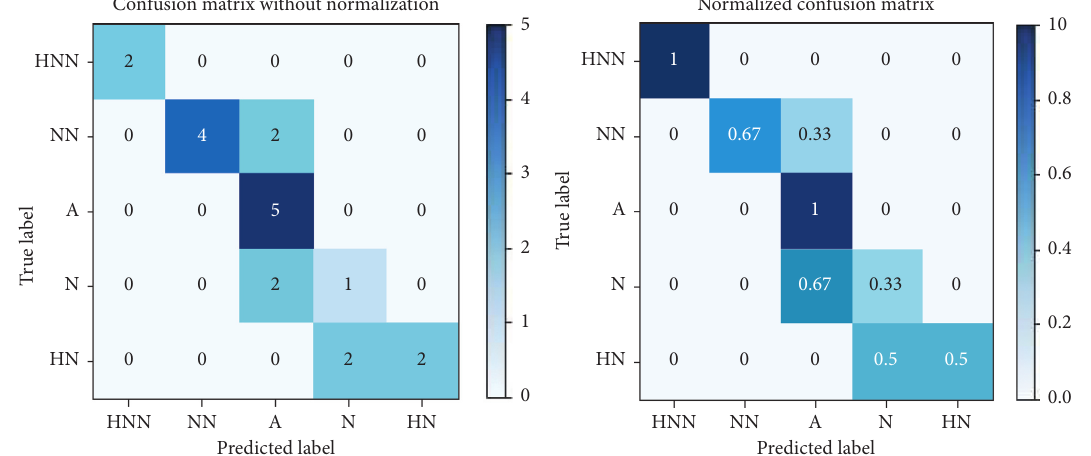
Figure 15: Confusion matrices without normalization for “ k � 5.”